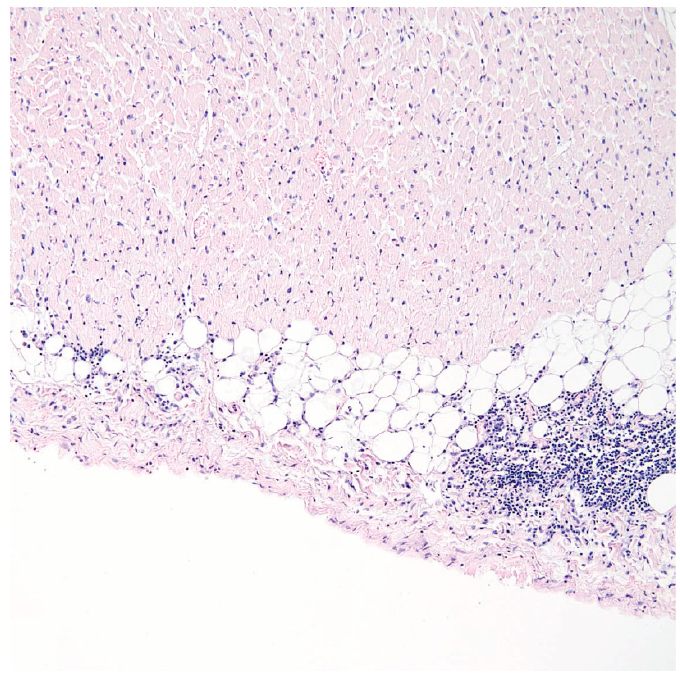
Figure 2. Epicardium, 40-year-old woman. Epicarditis with neutrophils and mononuclear cell infiltration. HE, ×100.